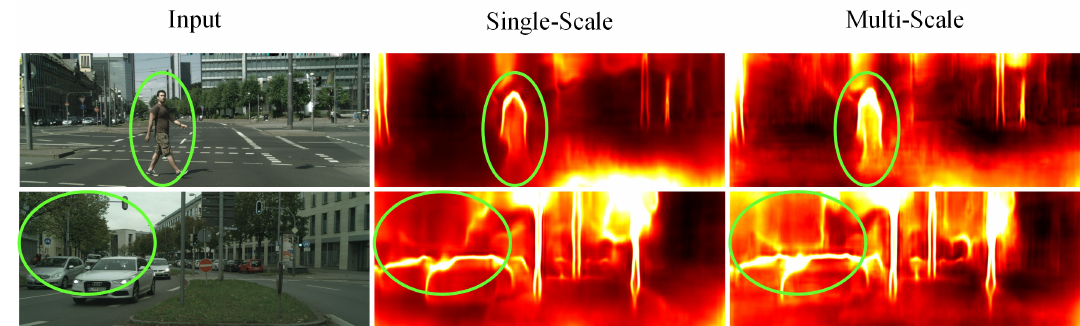
Figure 3. Depth uncertainty estimation cases. Multi-scale uncertainty obtain more depth uncertainty details than single- scale, especially in the geometric blur caused by moving targets (top) or relative motion between targets and tree in the background